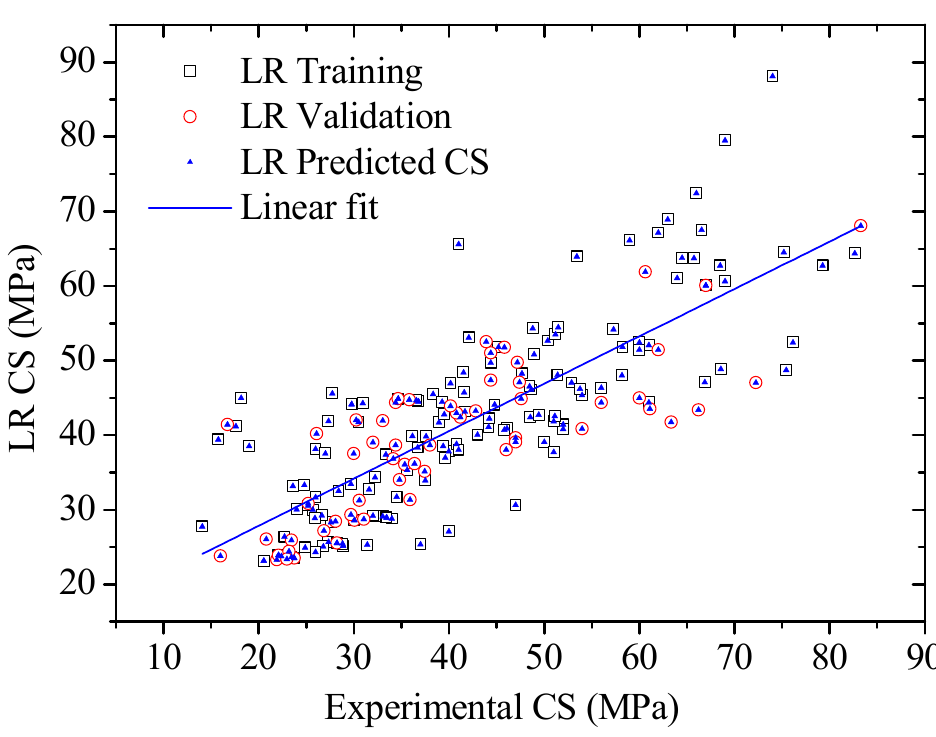
Figure 7. LR: training, validation, and